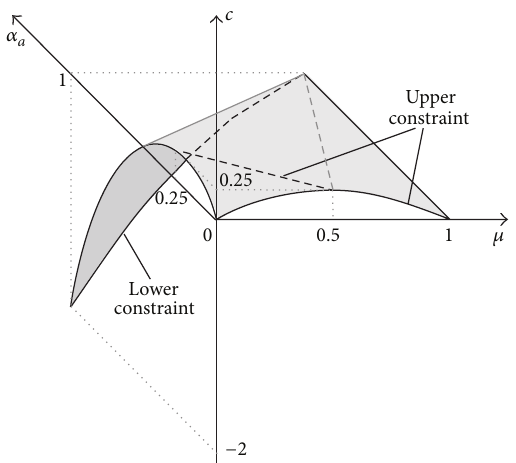
Figure 5: Full and complete 3D result of formula 𝐶 = 𝐴−𝐴 2 , where 𝐴 = [𝜇, 2 − 𝜇] , obtained with use of the multidimensional RDM FA (29), with marked upper (right) and lower (left) constraint of 2D membership function.